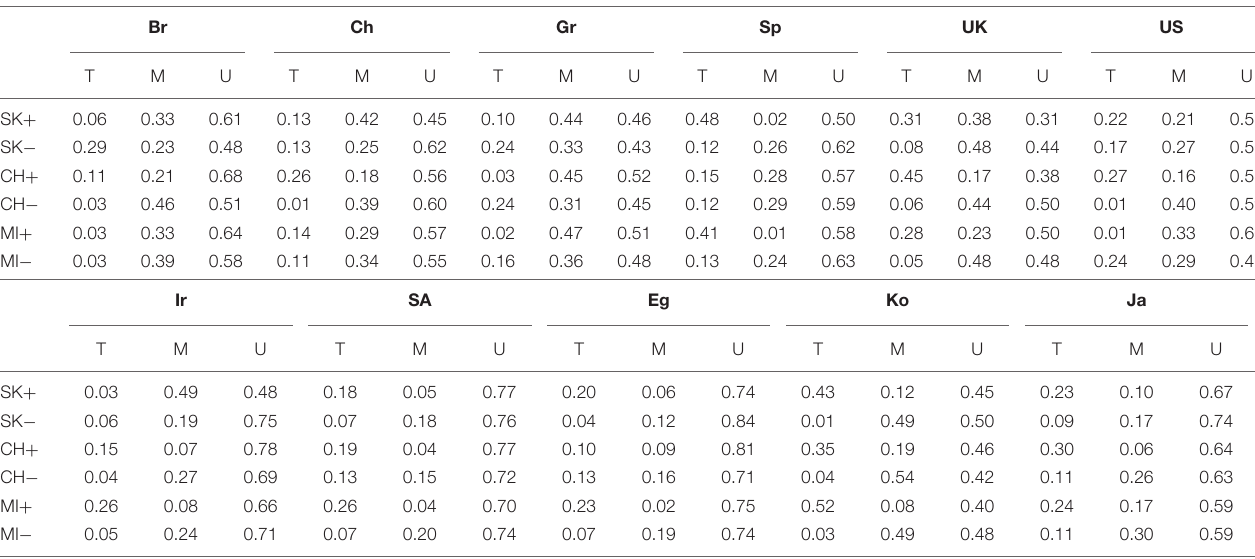
TABLE 4 | Averaged variance components for the SCS in the MTMM